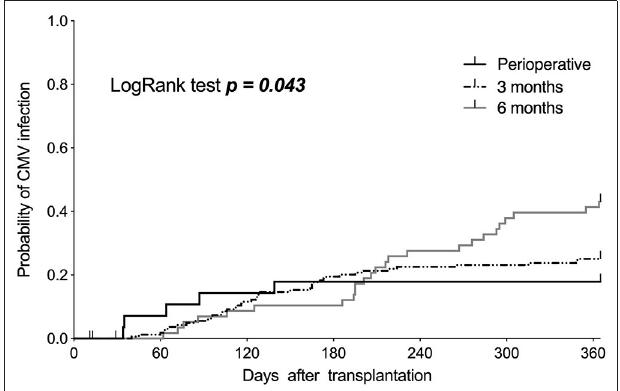
FIGURE 2 | Kaplan–Meier curves showing the incidence of cytomegalovirus (CMV) infections in the first year after kidney transplantation, stratified based on the duration of applied anti-CMV